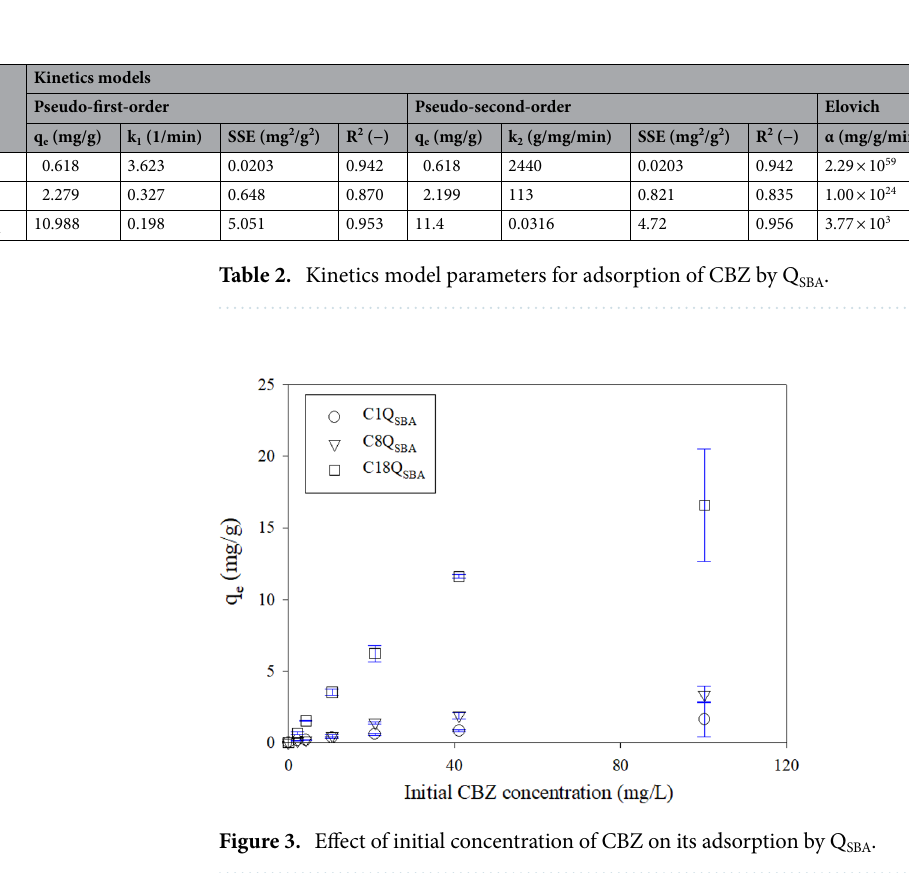
Figure 2. Effect of contact time on adsorption of CBZ by Q SBA .